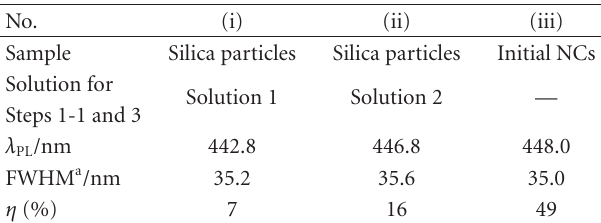
Table 1: PL peak wavelength ( λ PL ), spectral width (FWHM), and PL e ffi ciency ( η ) of silica particles incorporating the NCs together with the initial colloidal